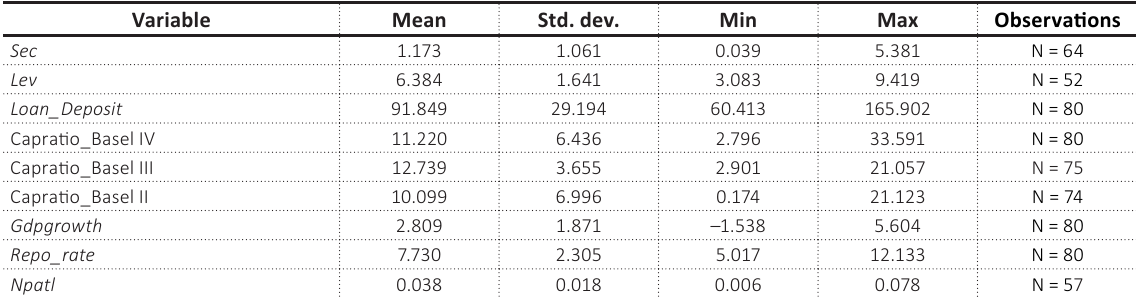
Table 2. Summary statistics of key